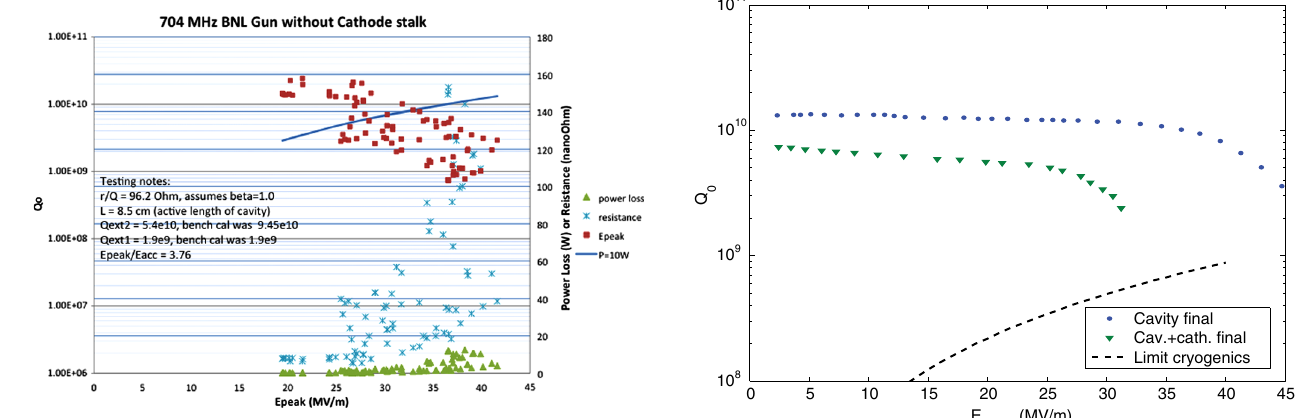
FIG. 10. Preliminary Q vs E peak measurements of the 1.3 GHz 1.6 cell BERLinPro SRF gun. Courtesy of Axel Neumann,